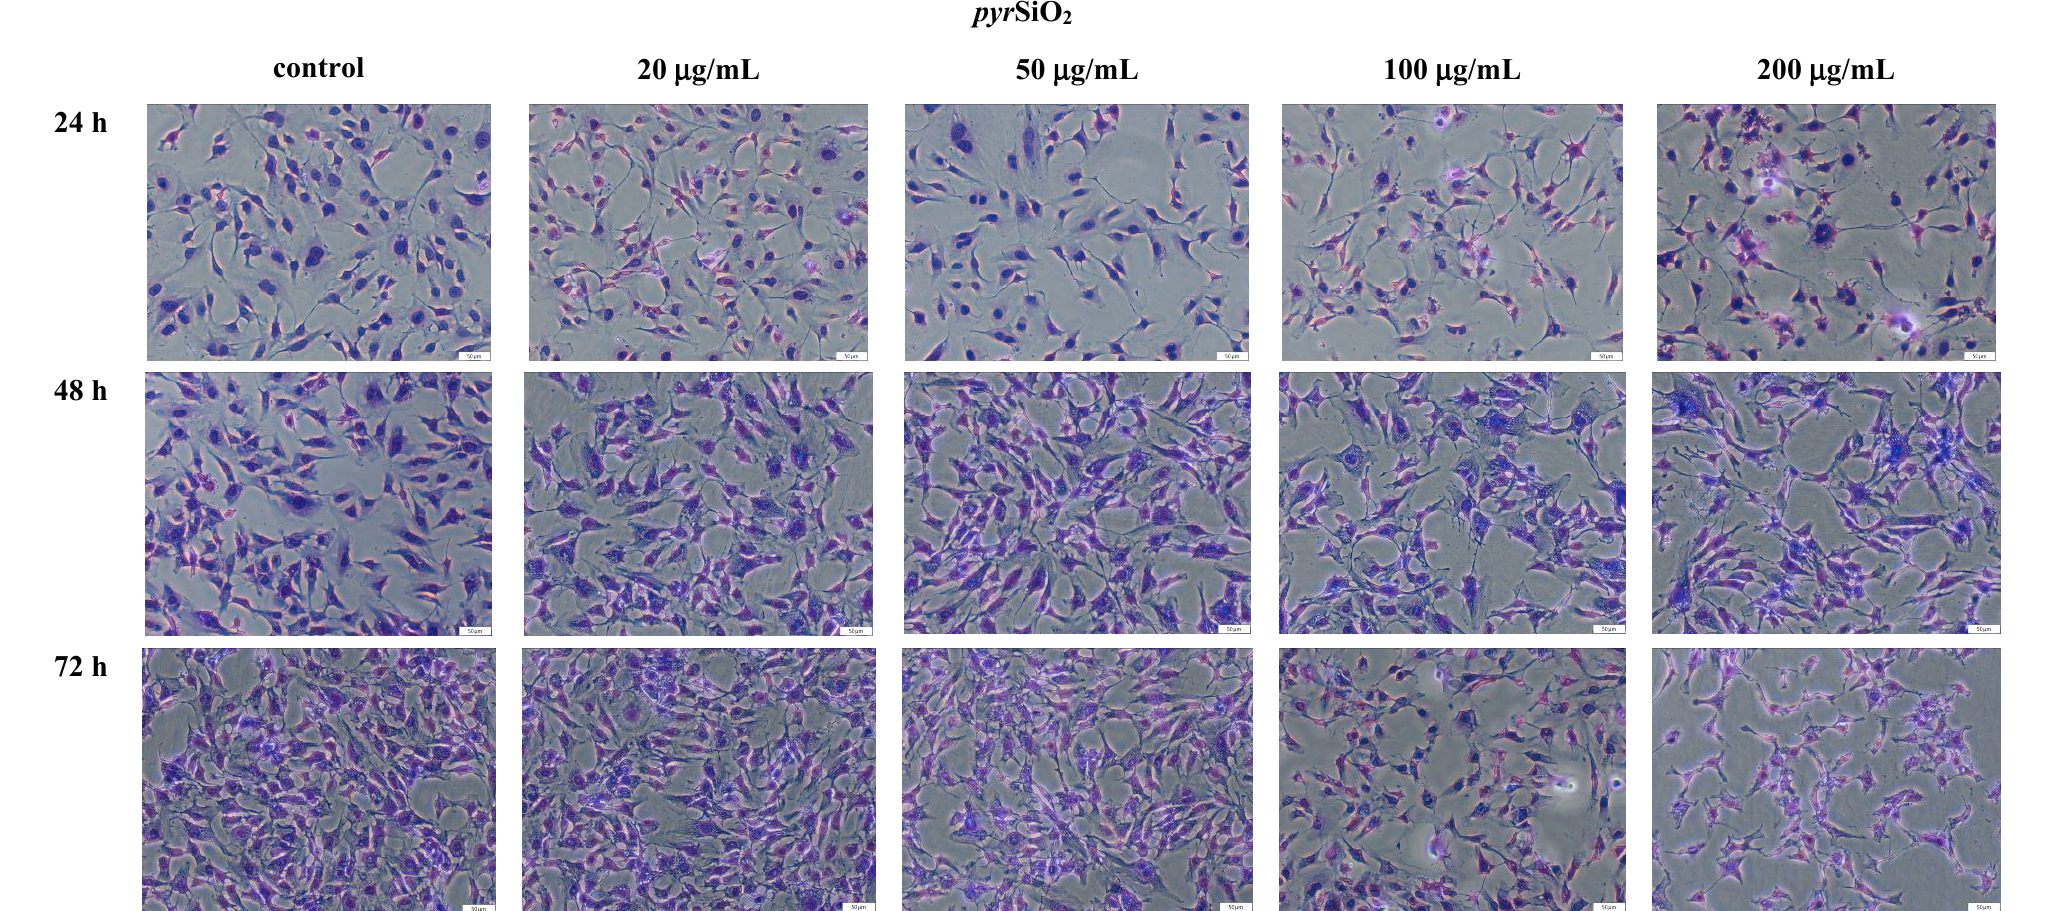
Figure 6. Morphological changes of the cells HMEC-1 before and after treatment with silica nanoparticles (pyrogenic) at concentration of 0–200 µ g/mL and after three periods of incubation. The scale bar corresponds to 50 µ